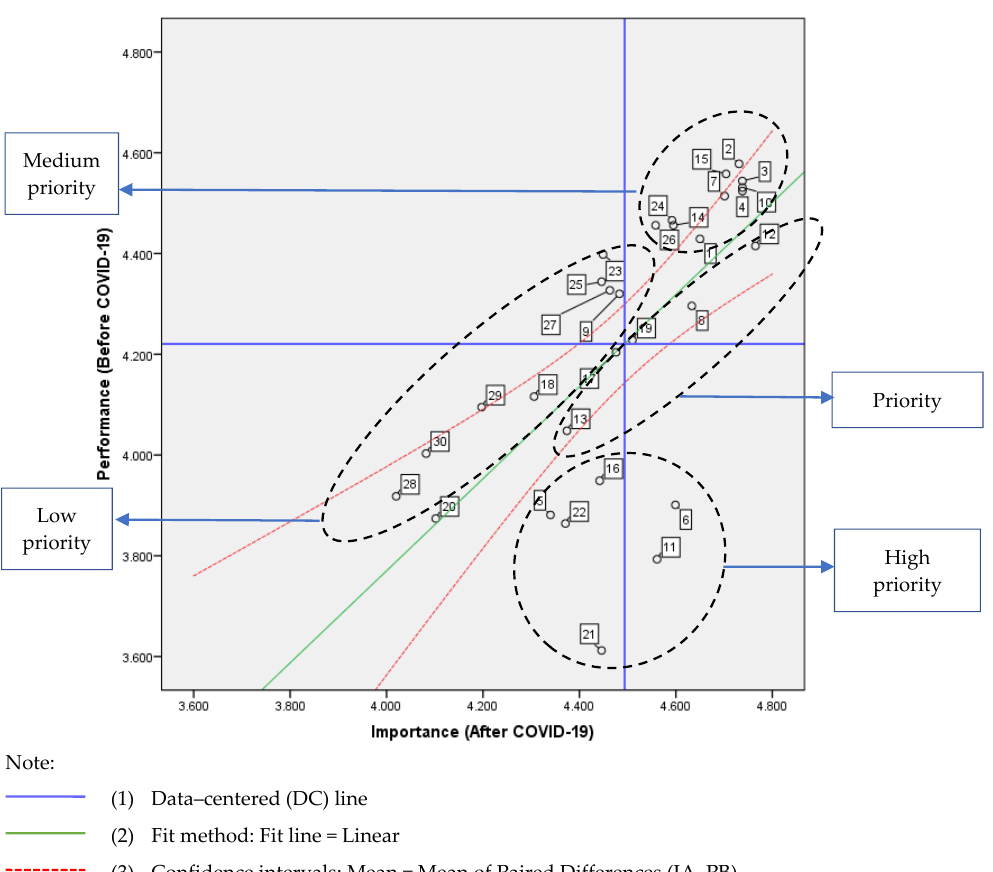
Figure 6. The importance (after COVID-19)-performance (before COVID-19) analysis model.